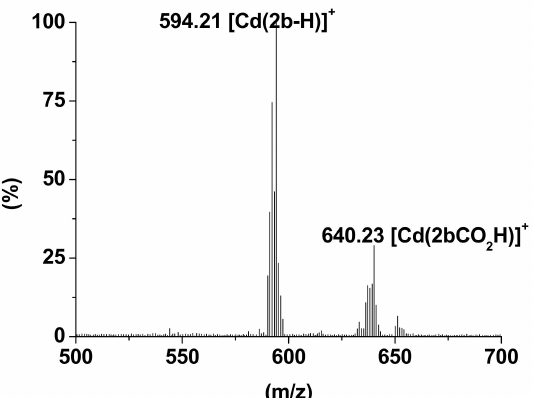
Figure 5. Cd 2+ complex of tolan ( 2b ) found from the positive ion mode electrospray ionization-mass spectrometry (ESI-MS) spectrum.